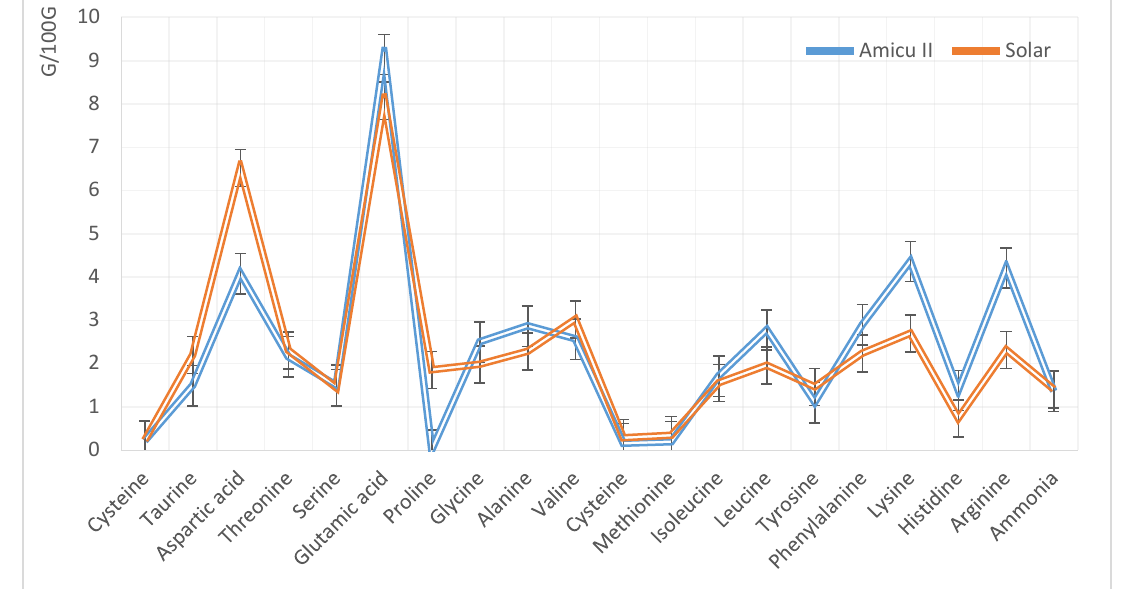
Figure 2. The content of amino acids in proteins of Jerusalem artichoke flour.